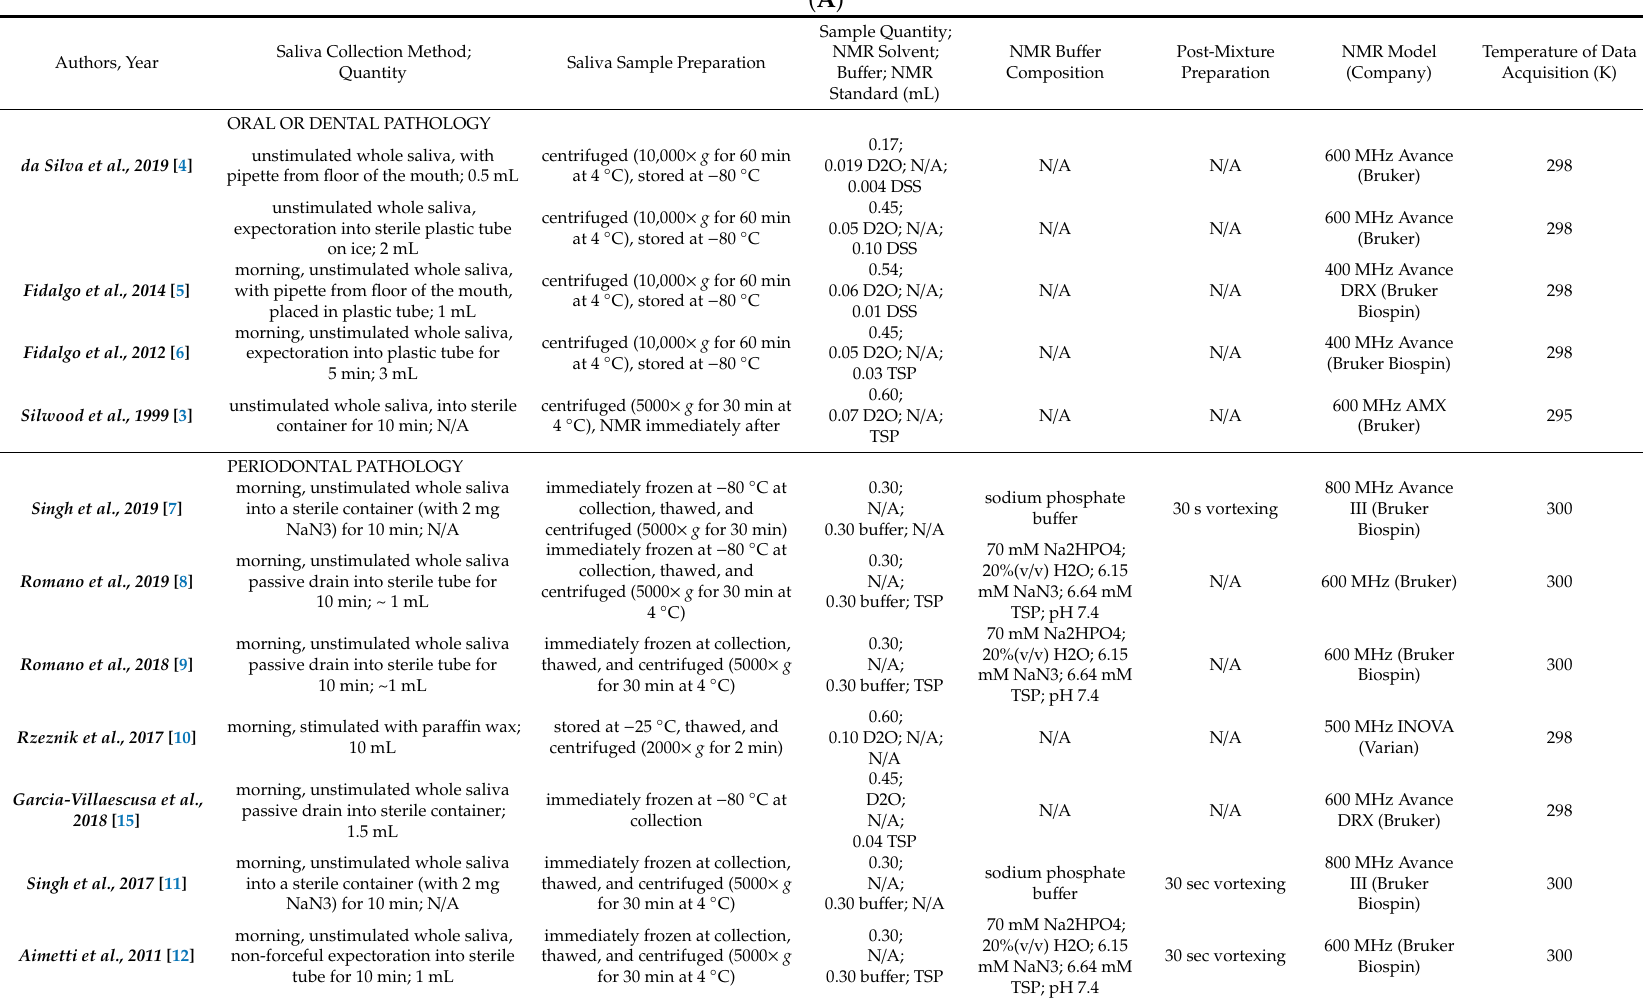
Table 1. ( A ) Methodology of nuclear magnetic resonance (NMR) saliva experiments and ( B ) significant metabolites reported per